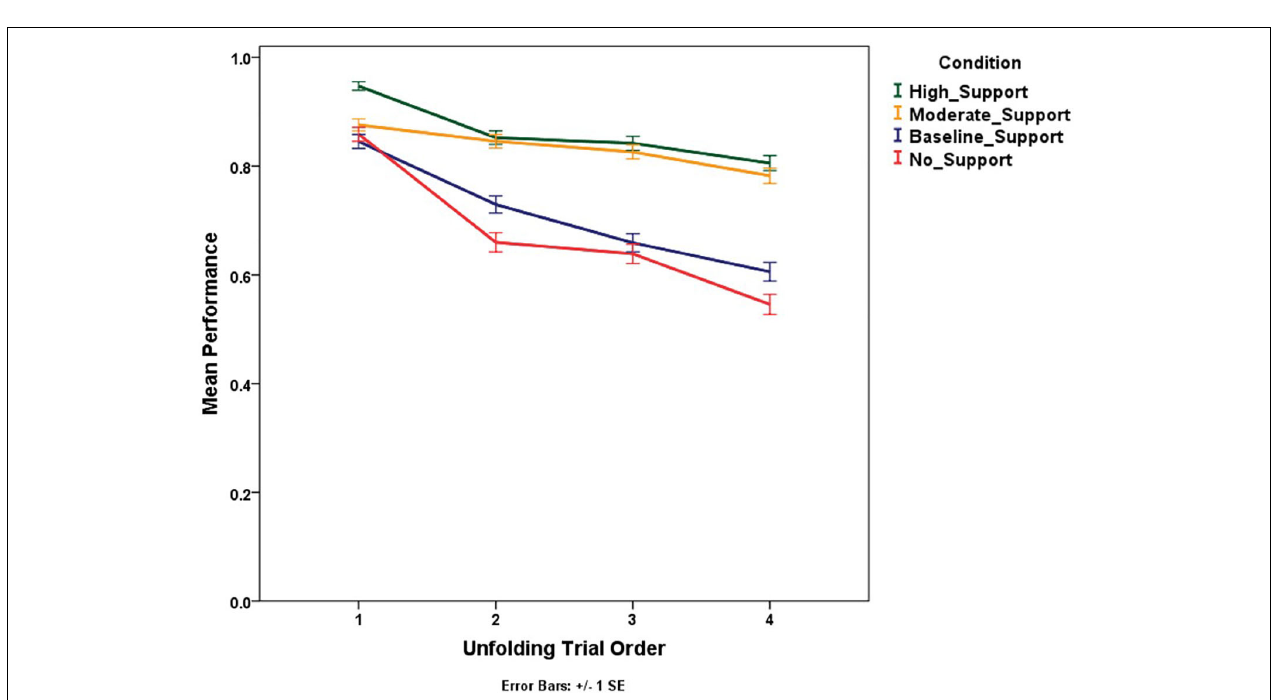
FIGURE 12 | Mean performance (proportion correct) trend for unfolding trials across conditions.